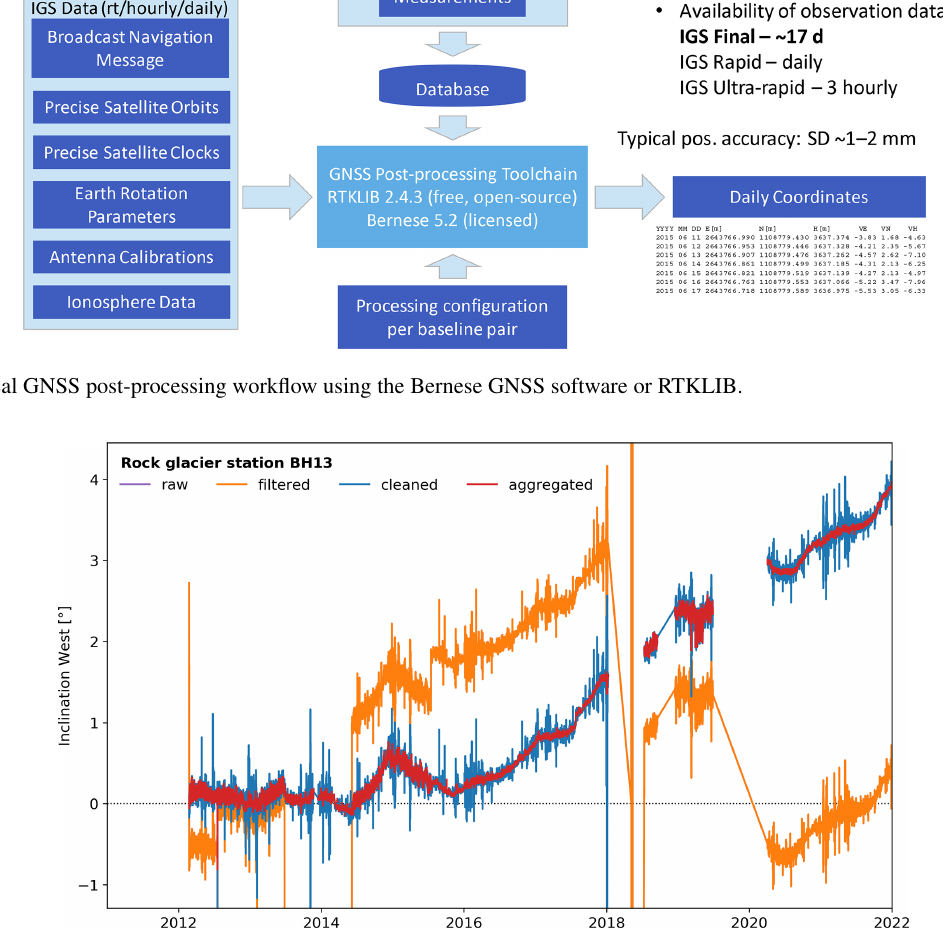
Figure 6. Data cleaning example: Inclinometer west-component time series data for location BH13 on the Gugla-Bielzug rock glacier has severe outliers and jumps in the raw data that can be removed, compensated for, and aggregated to smooth time series using the PermaSense Data